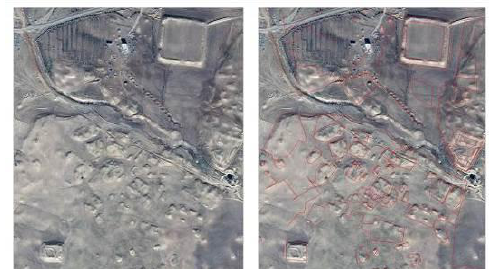
Figure 18 – Pleiades orthophoto of the Makhmúr al-Qadíma site with overlaid objects of interest on the right picture - RGB synthesis; GSD 0,5m